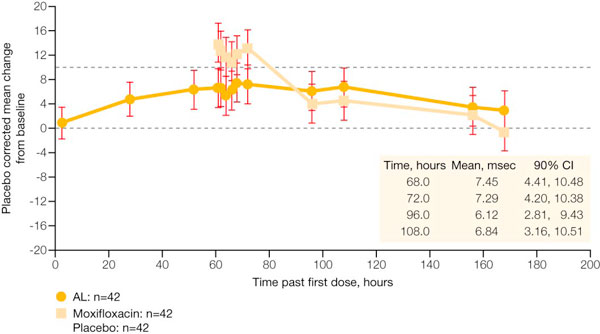
Placebo-corrected mean change in QTc (Fridericia's formula) from time-averaged baseline in healthy volunteers. [Data on file (study A2101), Novartis]. AL = artemether/lumefantrine; CI = confidence interval.